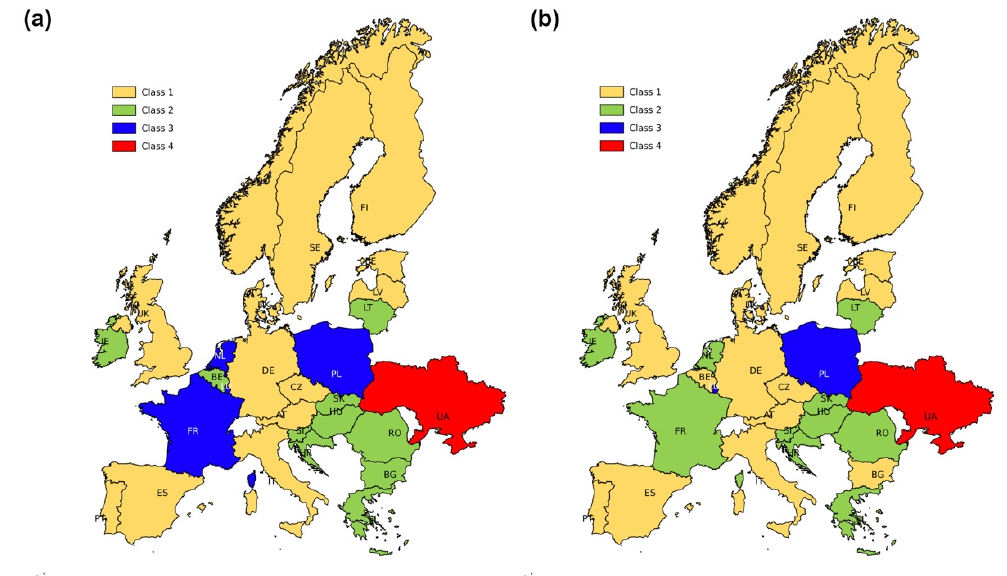
Figure 7. Results of the VMCM classification of European countries regarding renewable energy production with reference to the 2009 artificial pattern: ( a ) 2014; ( b ) 2018.